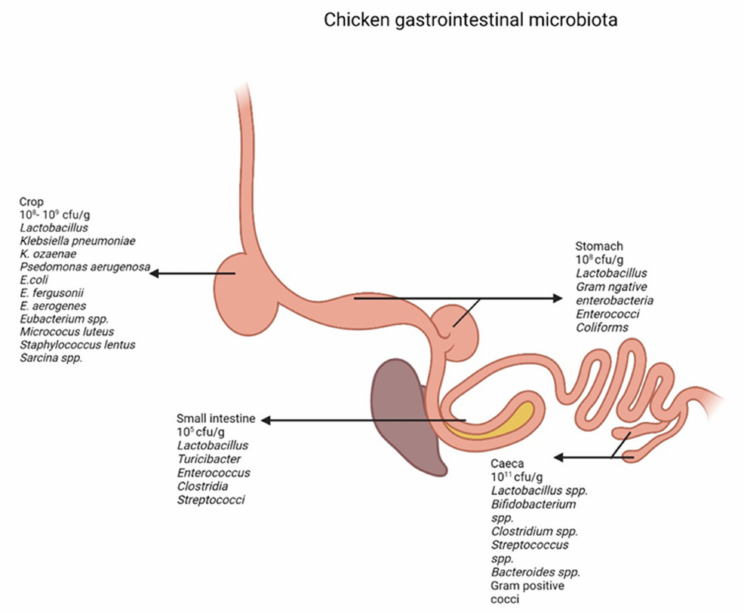
Figure 1. Regional abundance and diversity of gastrointestinal microbiota of chicken. Created with BioRender.com (26 March